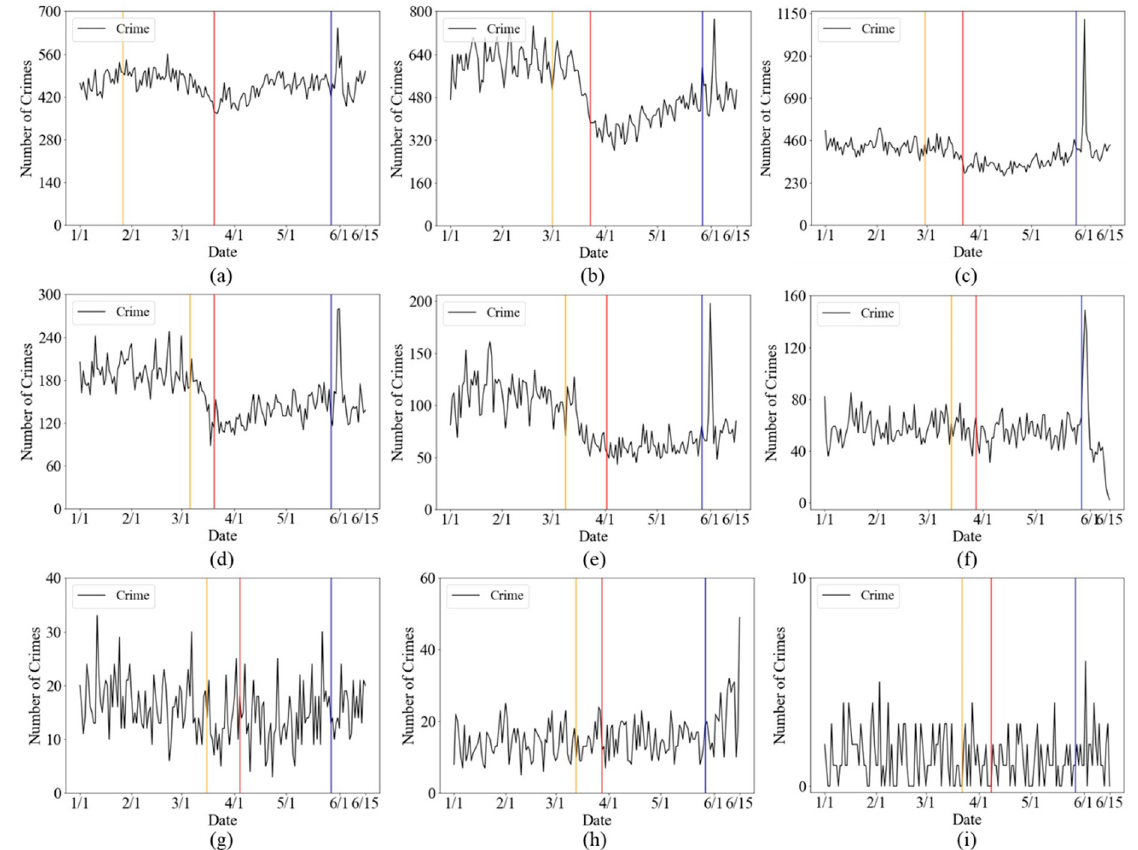
Figure 4. Time series of crimes per day ( a ) Los Angeles County, CA; ( b ) New York City, NY; ( c ) Chicago, IL; ( d ) San Francisco, CA; ( e ) Washington, D.C.; ( f ) Minneapolis, MN; ( g ) Shelby County, AL; ( h ) Olmsted County, MN; ( i ) Newberry County, SC. Yellow vertical line indicates the date first confirmed case reported, red vertical line indicates the date stay-at-home order implemented, and blue vertical line indicates the death date of George Floyd (26 June 2020).